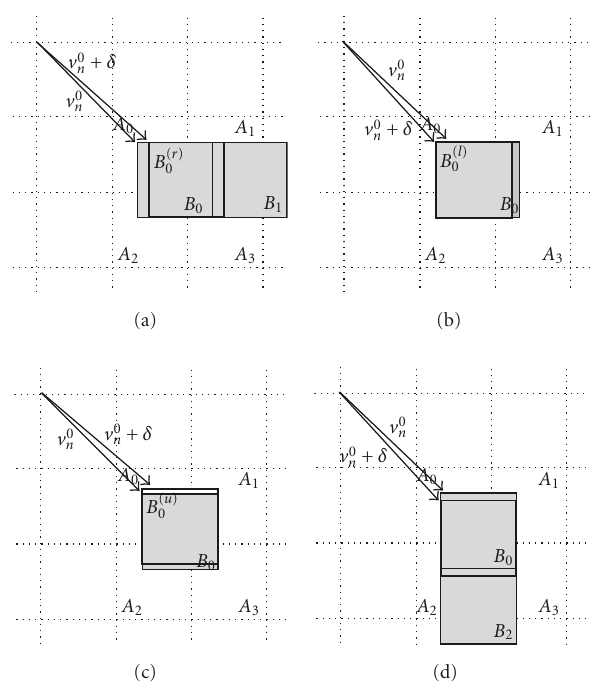
Figure 6: Overlap property of MC block predicted by + δ , where δ = { (1,0),( − 1,0),(0,1),(0, − 1) } . (a) Overlap property of B + (1,0). (b) Overlap property of B 0 predicted by v 0 by v 0 n (c) Overlap property of B 0 predicted by v 0 property of B 0 predicted by v 0